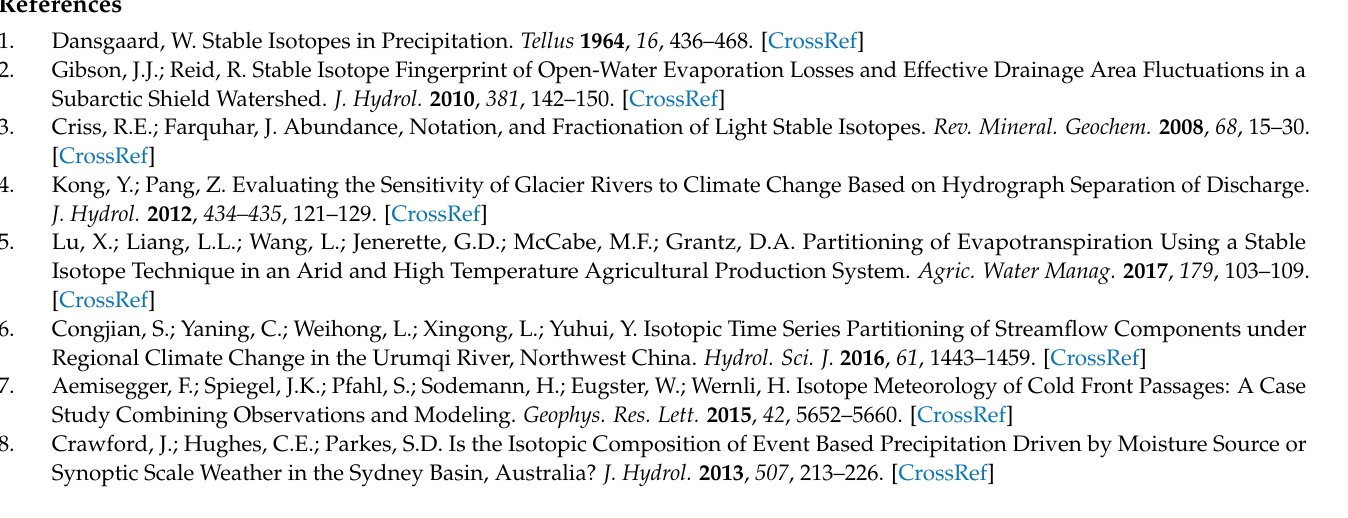
Figure 3. Figure S1: Graphical details of the Spearman test between the monthly meteorological variables and the isotopic signal, shown in Table